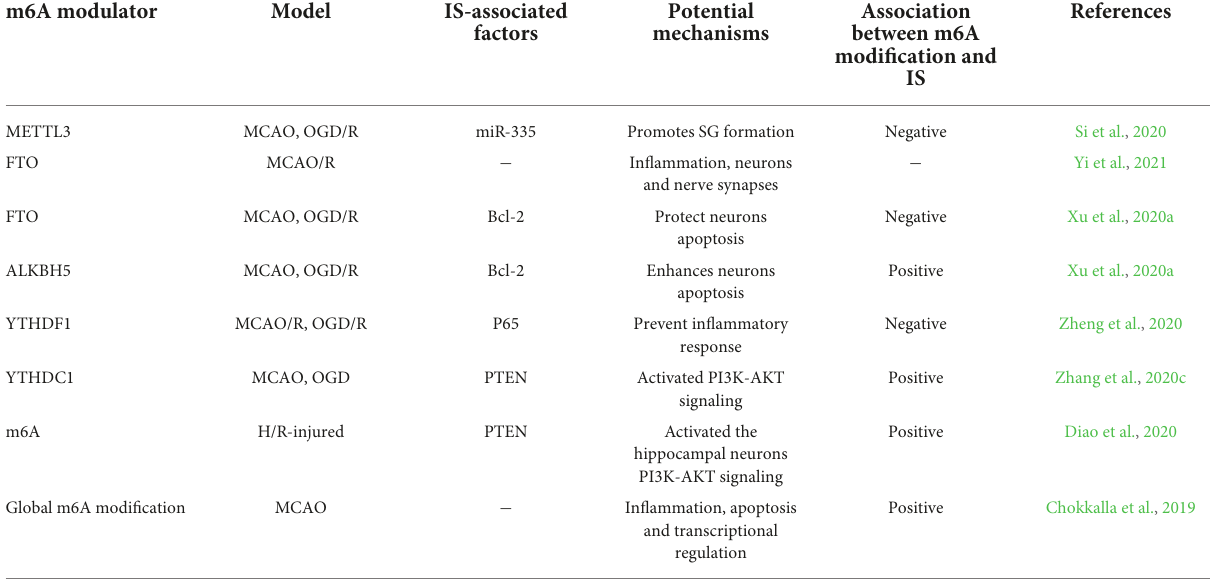
TABLE 1 The regulation of m6A RNA modification and its potential mechanism in ischemic stroke